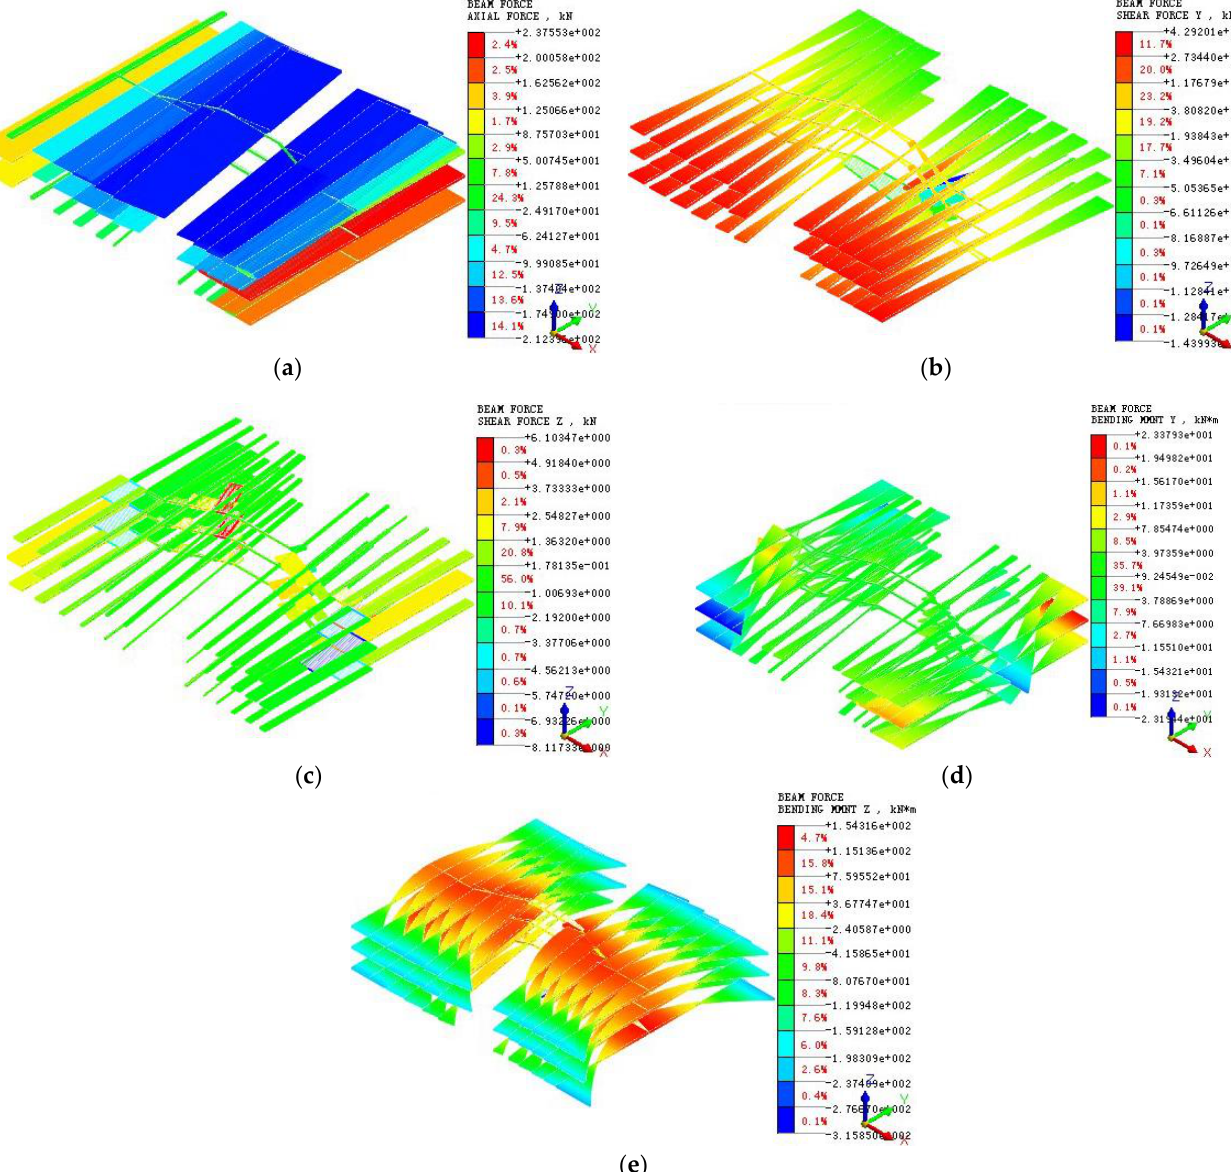
Figure 11. Contours of internal forces in steel strut at Excavation Step 8: ( a ) Axial force; ( b ) Shear force in Y direction; ( c ) Shear force in Z direction; ( d ) Bending moment in Y direction; ( e ) Bending moment in Z direction.